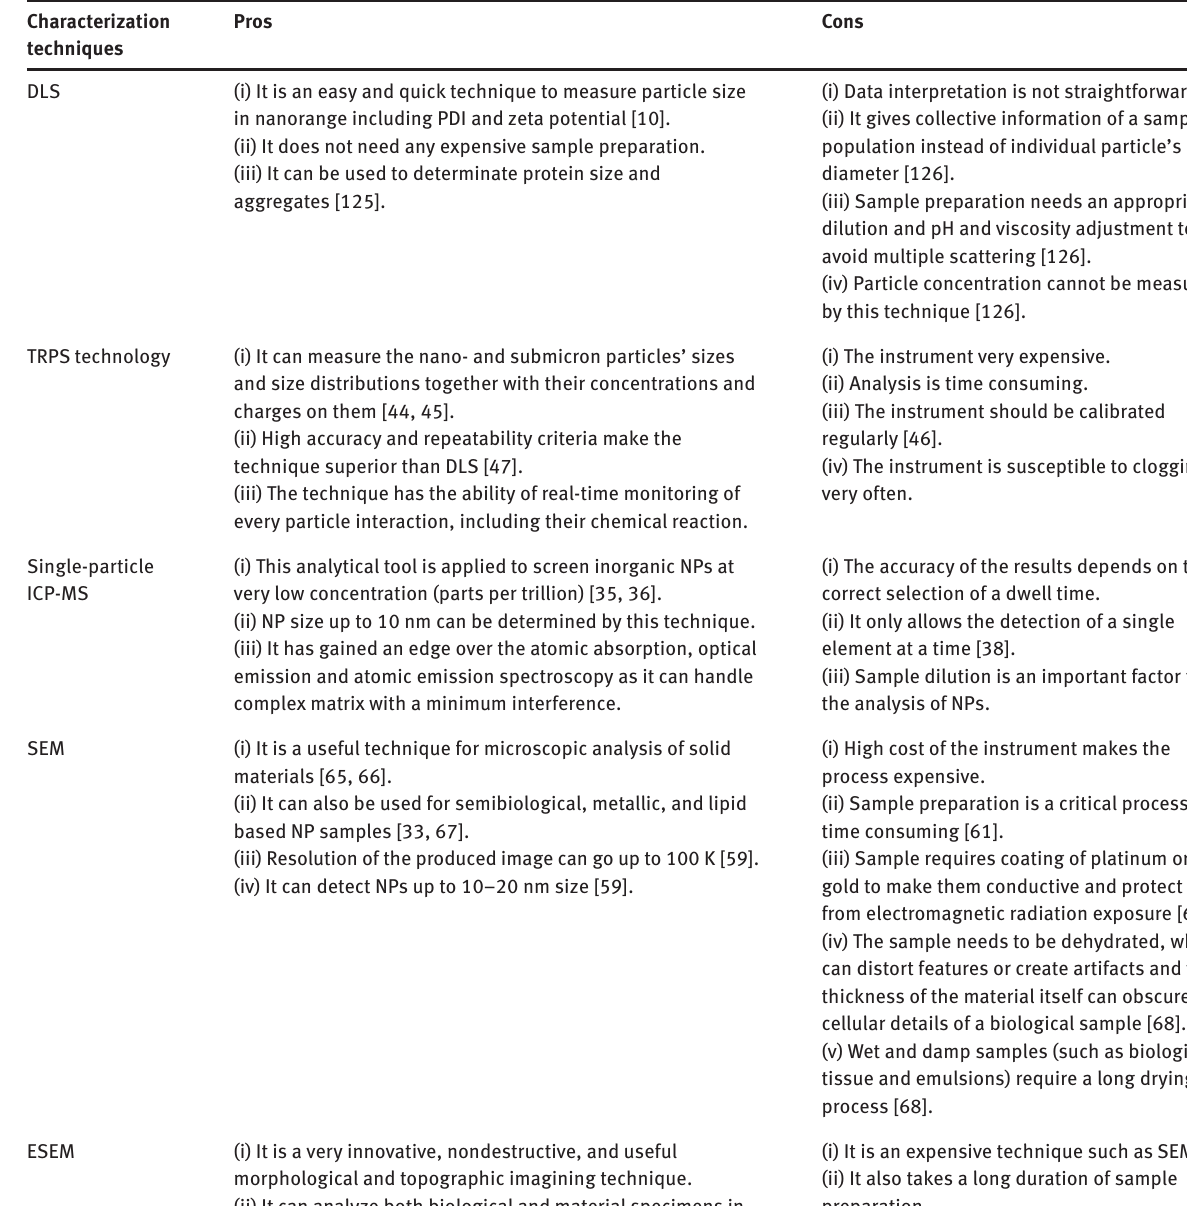
Table 1: Pros and cons of techniques used for NP